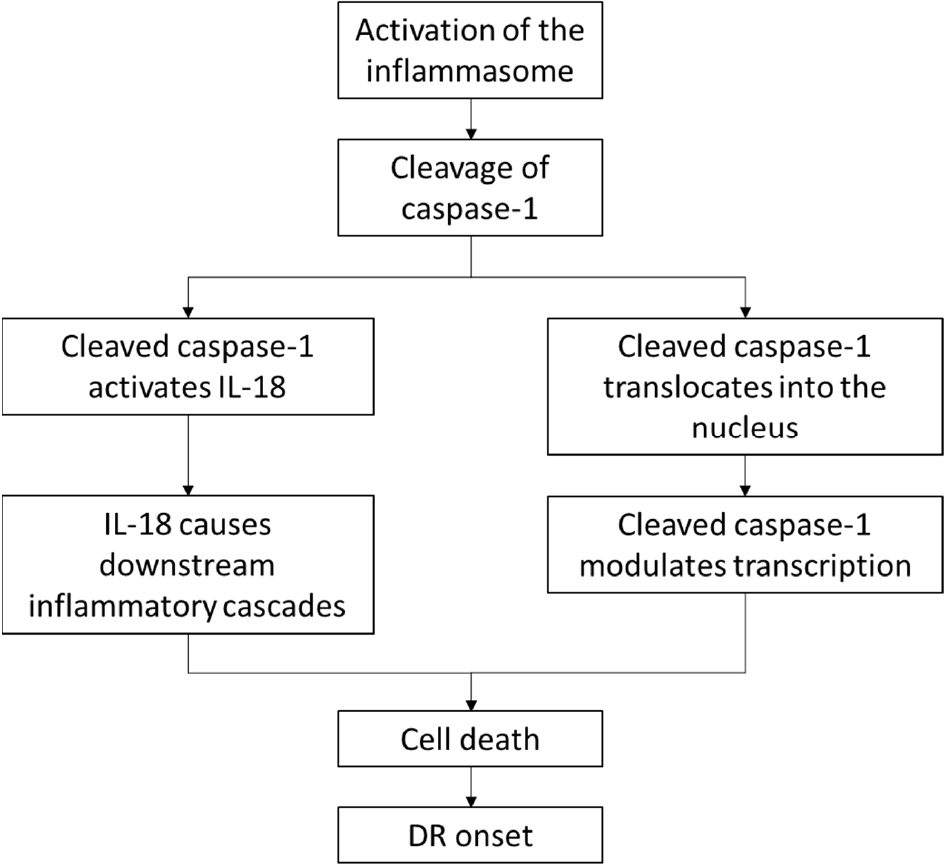
Figure 9. Following activation of the NLRP3 inflammasome, caspase-1 is cleaved. Cleaved caspase-1 can promote DR onset by activating IL-18 or can be translocated into nuclei in the INL and ONL, and play a role in gene transcription contributing to DR onset.